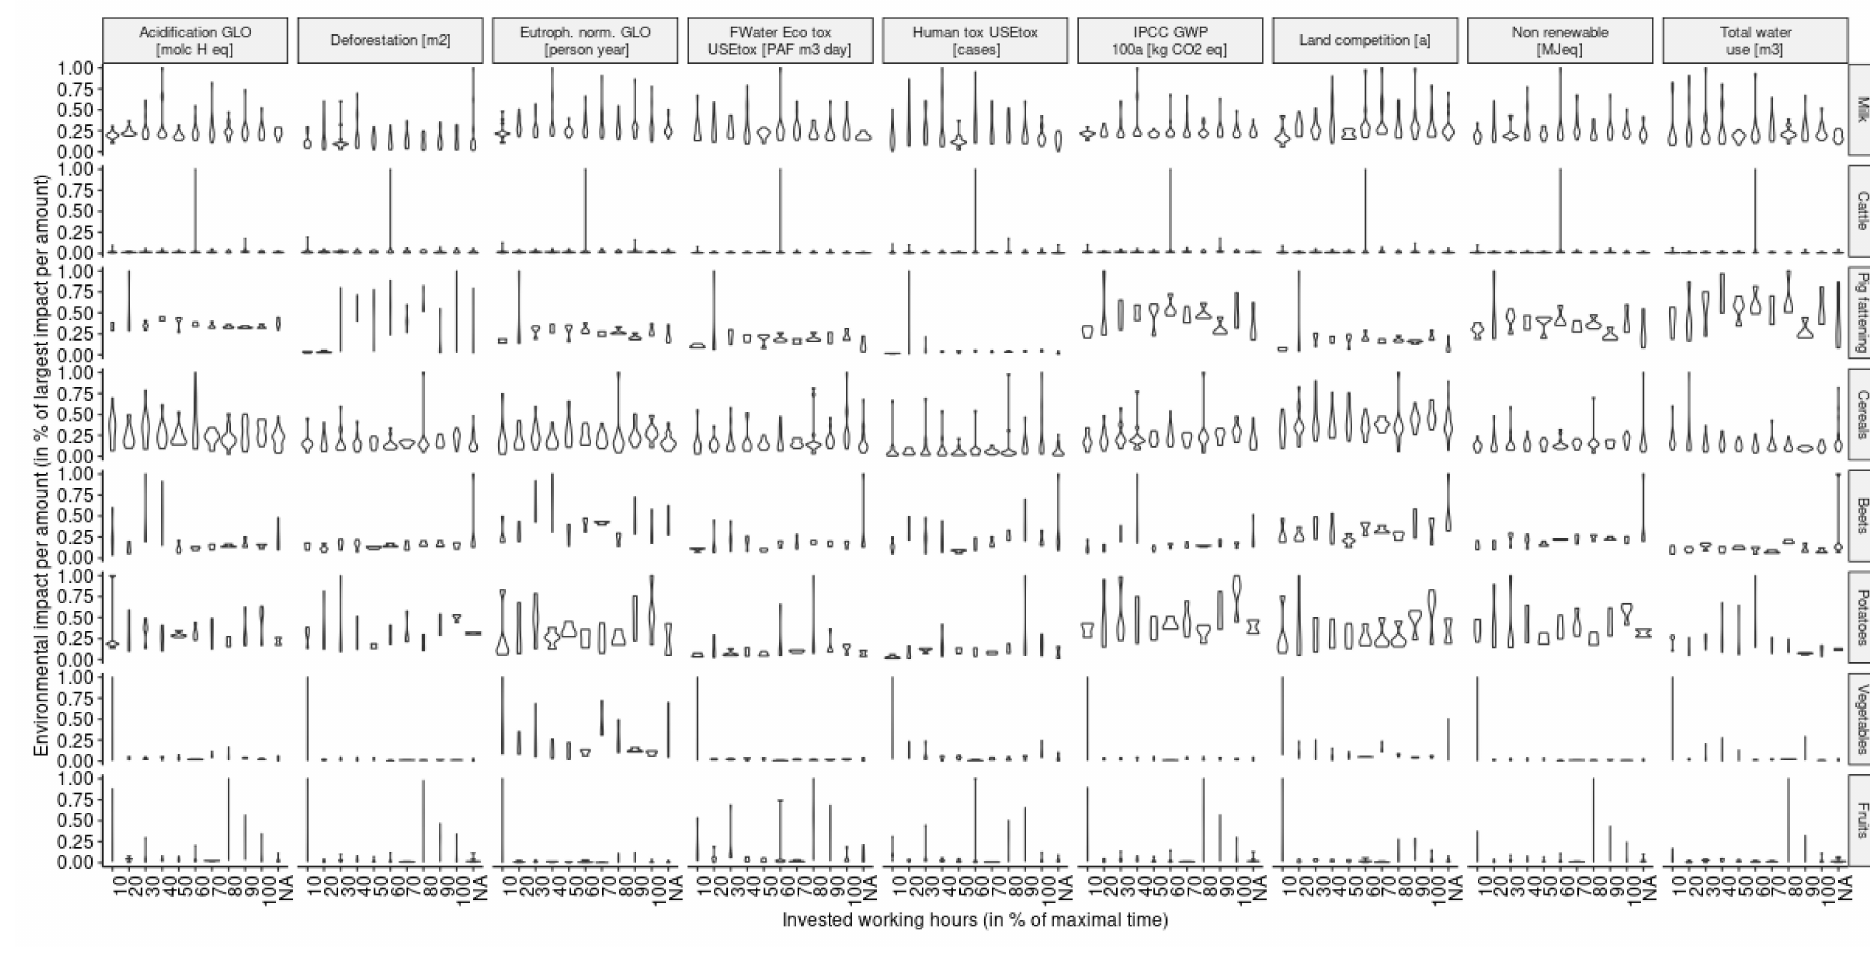
Figure A4. Variance in environmental efficiency estimate vs. product group size (measured as working hours). Smaller product groups show larger variance in estimates. (PAF m 3 day = potentially affected fraction of species integrated over time and volume, eq = equivalent, MJ =